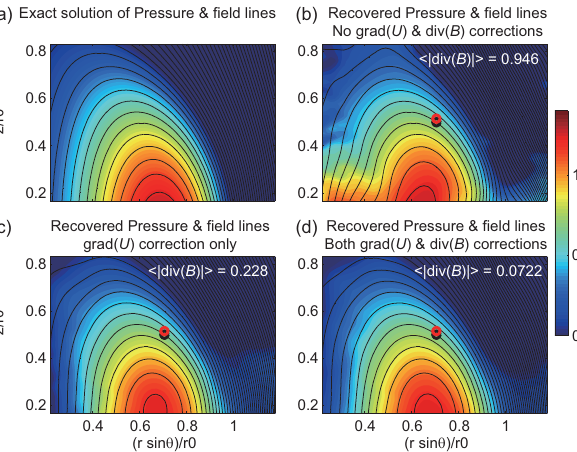
Figure A2. Comparison between (a) exact solution and benchmark reconstructions with (b) no corrections, (c) ∇ U correction only, and (d) both ∇ U and ∇ · B corrections (see Appendix for details). The format is the same as in the right panels in Fig. 6a of SH11; poloidal field lines are shown in a meridional plane at ϕ = π/ 4, with plasma pressure in colour. Small circles indicate the locations at which the Sc-A (black) and Sc-B (red) paths cross the plane. The number at the upper-right of each panel shows the mean absolute value of ∇ · B , as a measure of the quality of the numerical integration.